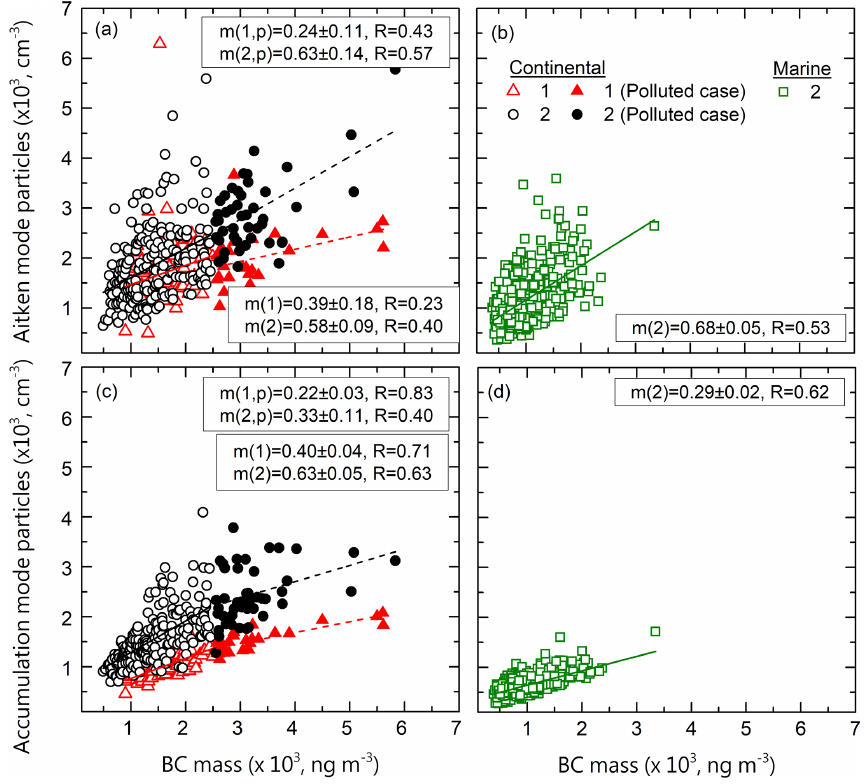
Figure 13. Association of BC mass concentration with Aitken ( a, b ) and accumulation ( c, d ) mode particles segregated for different air mass and loading conditions. The least-square linear fit lines are also